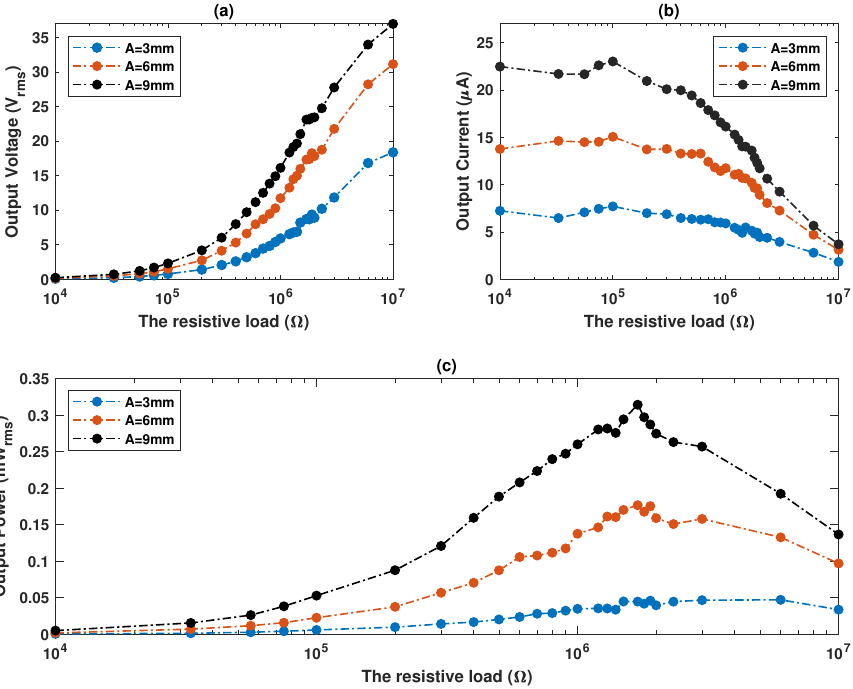
Figure 12. ( a ) RMS of voltage, ( b ) current, and ( c ) electric power of the piezoelectric vibration energy harvester for piezoelectric benders connected in series at different amplitudes of oscillation as a function of external load